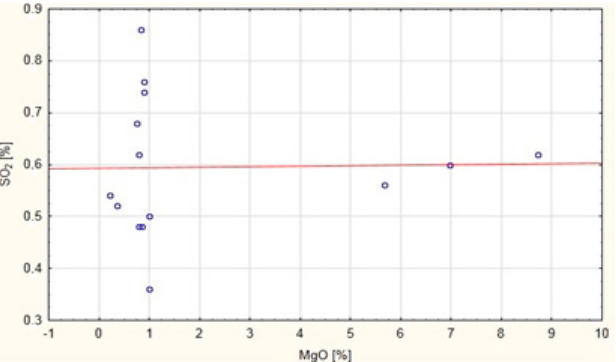
Figure 15. Relation between the amount of sulfur SO 2 (%) of the post-reaction product and the MgO (%) content of carbonate sorbent [21].